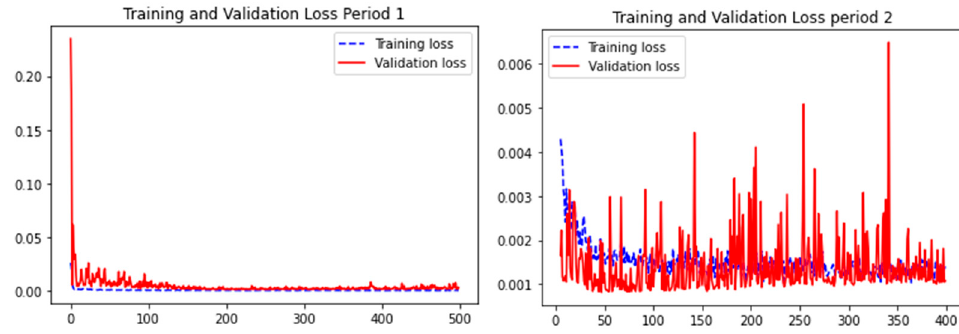
Figure 3. Training and validation loss of LSTM.